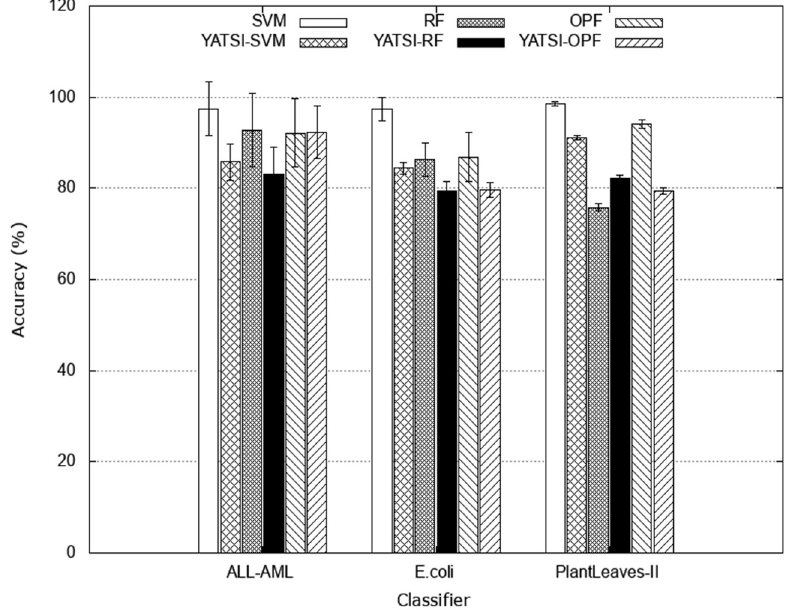
Fig 4. Average accuracies obtained by baselines approaches without considering sample selection strategies, using the ALL-AML , E.coli , and Pl@ntLeaves II datasets and the classifiers (SVM, YATSI-SVM, RF, YATSI-RF, OPF, and